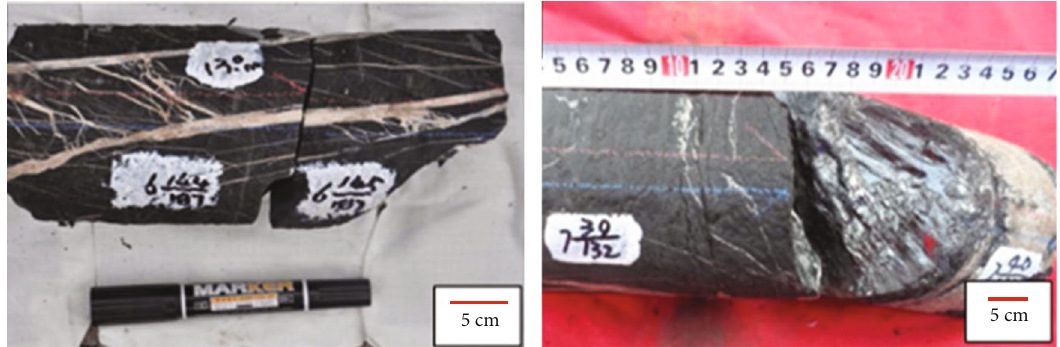
Figure 11: Detachment layers developed at the bottom of the Lower Cambrian in southeastern Chongqing area. (modi fi ed from Wang et al. [167]).